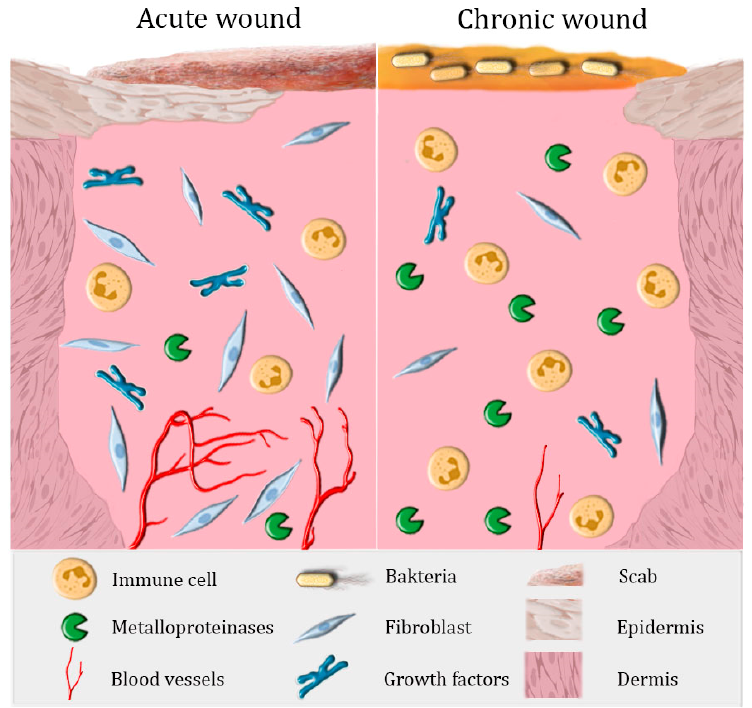
Figure 1. Schematic comparison of chronic and acute wound microenvironment.